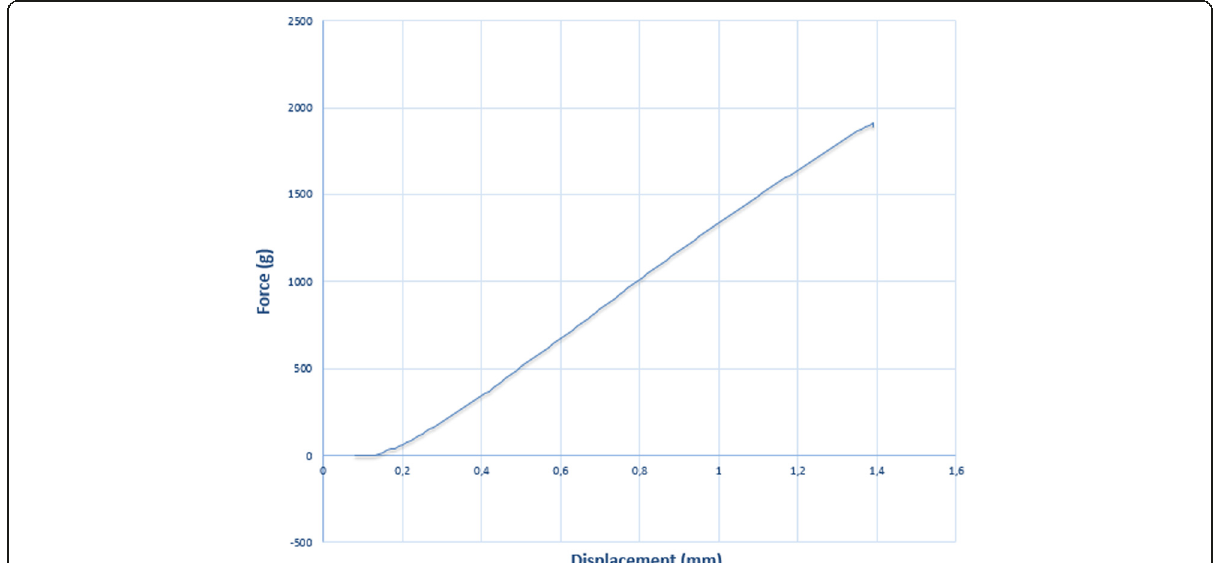
Fig. 4 Example of a Load/Deflection curve of a 0.018 X 0.018 SS lingual straight archwire